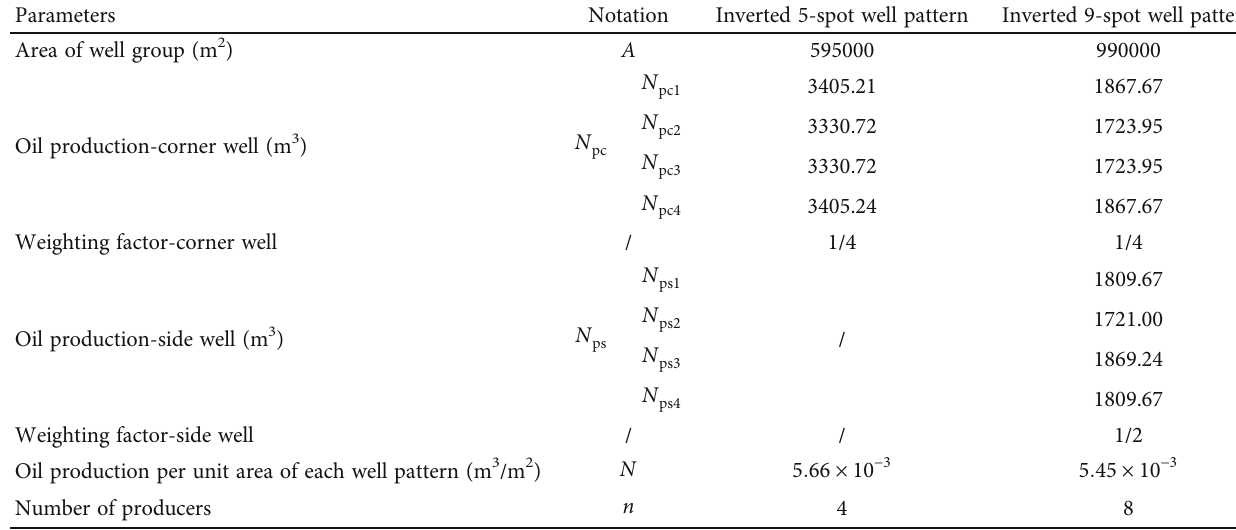
Figure 7: Cumulative oil production for the scenarios with di ff erent well spacing (inverted 9-spot well pattern). Table 5: Evaluation of optimal well